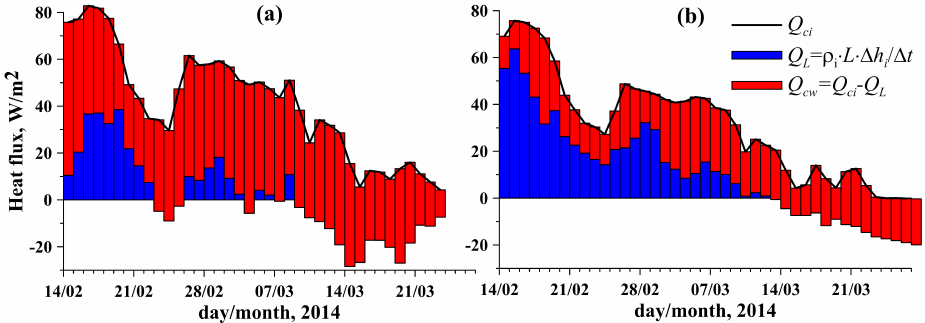
Figure 10. Daily averaged heat balance at ( a ) Station 1 and ( b ) Station